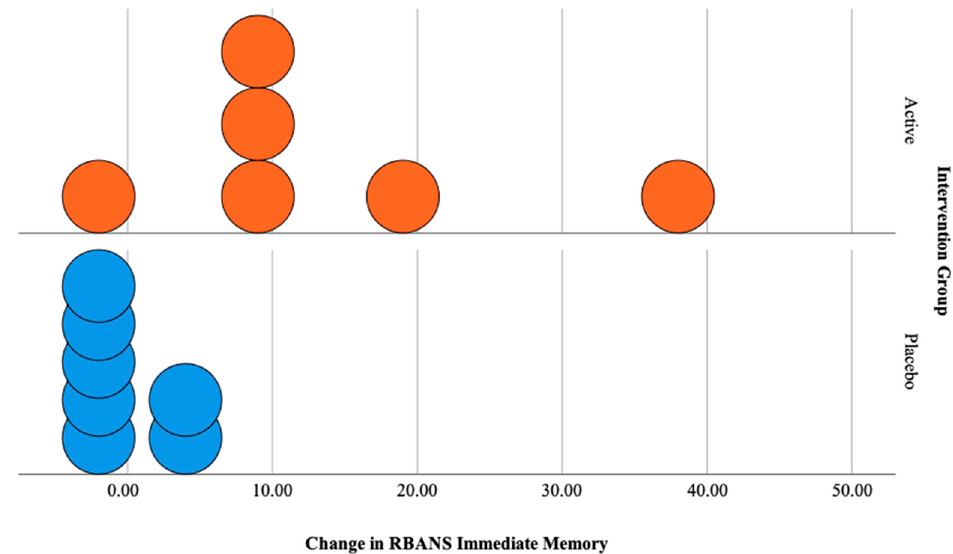
Figure 3. Dot plots illustrating change in individual scores recorded for the immediate memory domain of the RBANS for active and placebo intervention groups.